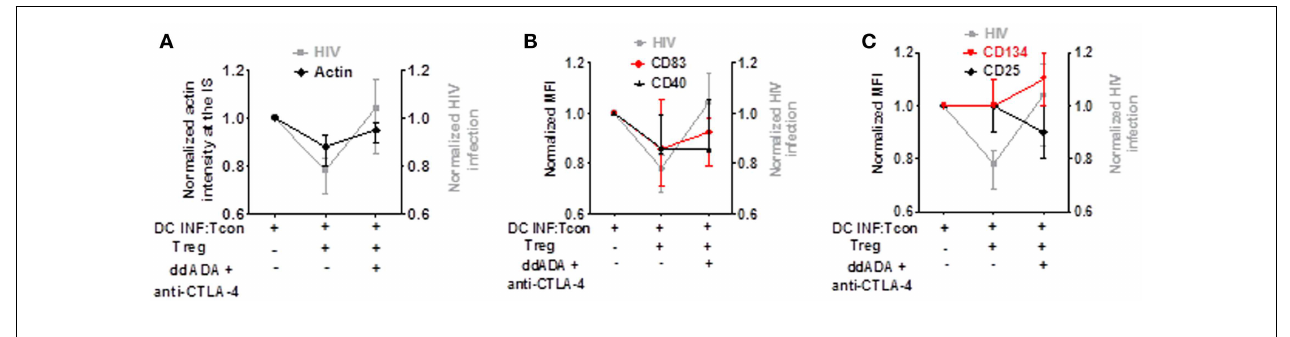
actin polymerization. (B) Blockade ofTreg function on HIV infection or CD83 and CD40 expression. (C) Blockade ofTreg function on HIV infection or CD25 and CD134 expression. Median of 6 (for actin polymerization) and 7 (for CD83, CD40, CD25, and CD134) experiment is